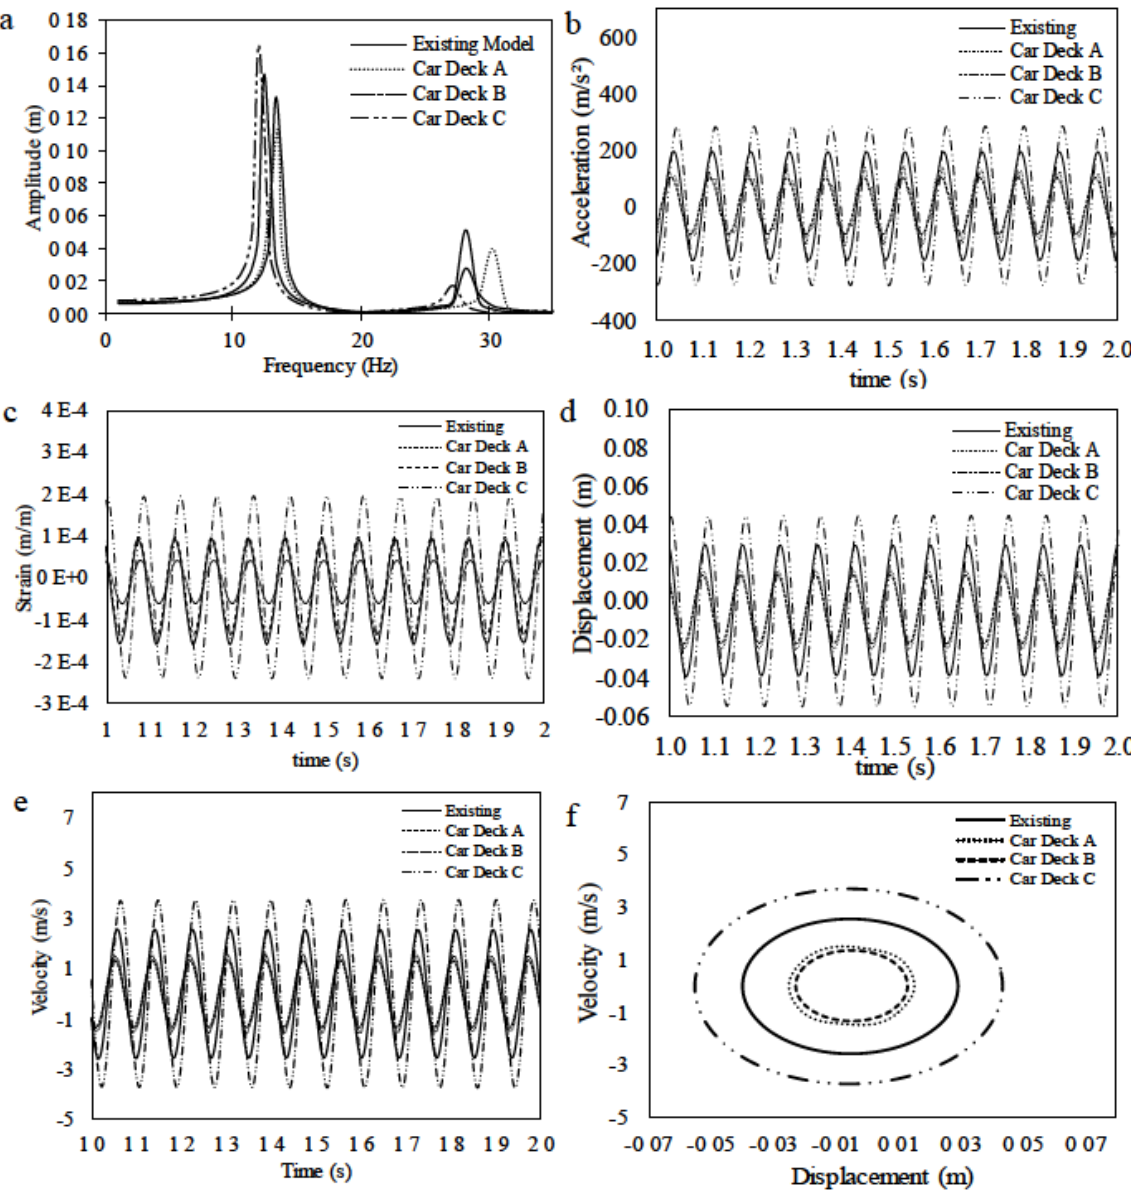
Figure 4: (a) FRF, time history responses: (b) acceleration, (c) strain, (d) displacement, (e) velocity, (f) phase